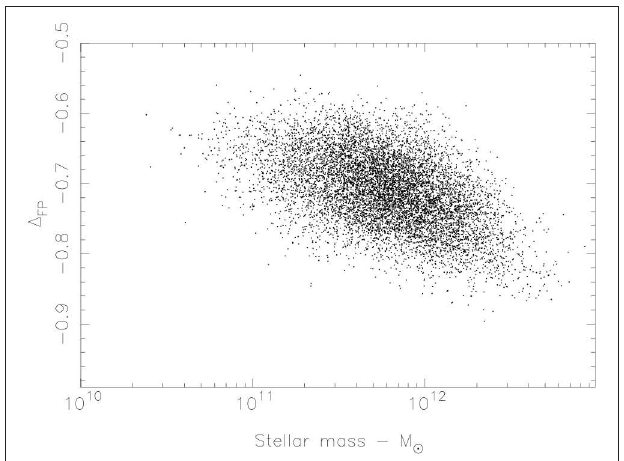
FIGURE 2 | Deviation from the virial plane. 8,971 6dF galaxies. The values of a and b defining the virial plane are those of Magoulas et al. (2012). An IMF dependence on stellar mass could be a key influence here (Conroy and van Dokkum, 2012; Conroy et al., 2013 ), but the real situation could be more complex (see text).